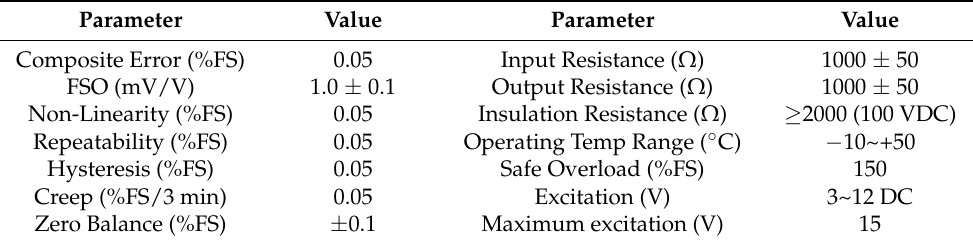
Table 1. Parameter index of the resistance strain gauge load